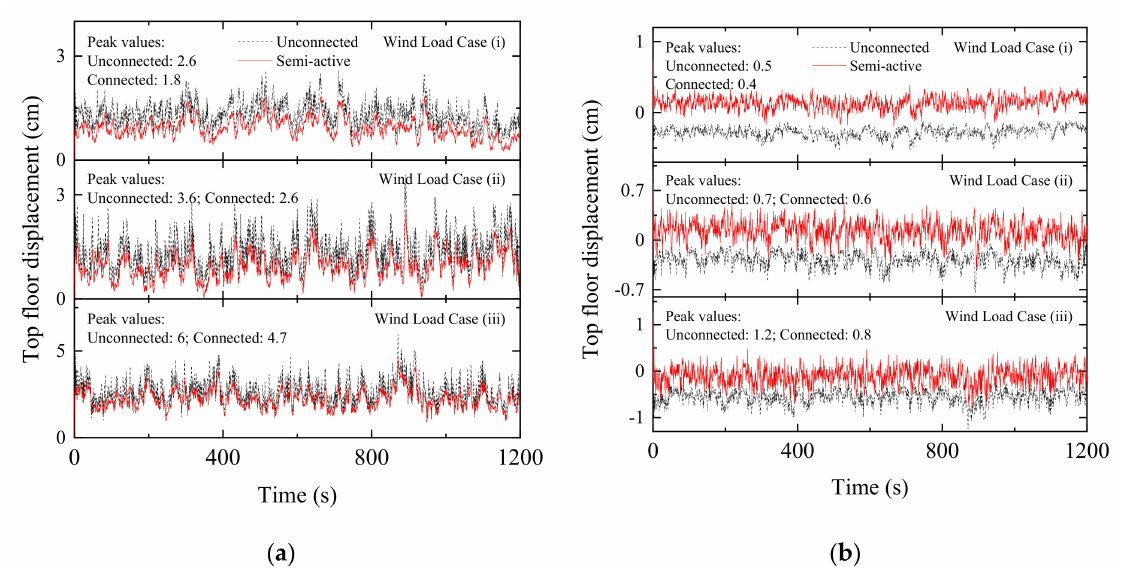
Figure 20. Time history of top floor displacement under wind excitation in: ( a ) a building on the upwind side and ( b ) a building on the downwind side when stiff adjacent buildings are connected using semi-active MR dampers following damper Configuration 1.